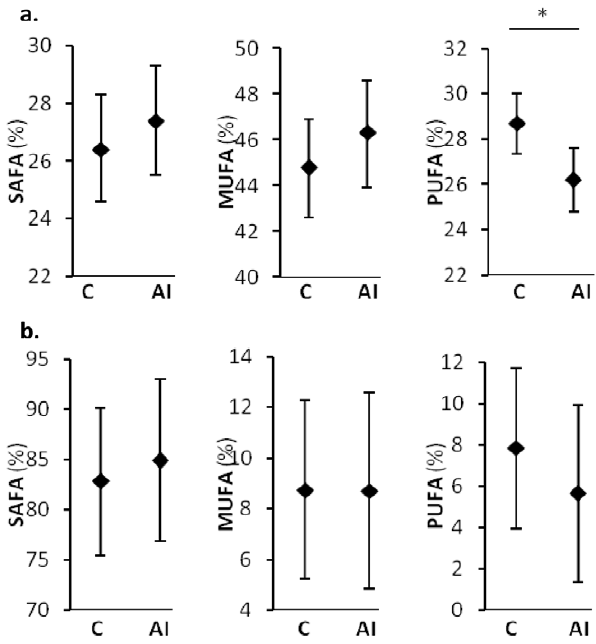
Figure 1. Plasma and CSF fatty acid fractions by race. Percentual abundance of saturated (SAFA), monounsaturated (MUFA) and poly- unsaturated (PUFA) fatty acids in plasma ( a. ) and CSF ( b. ) are shown for Caucasian (C) and American Indian (AI) individuals in plasma and CSF. Diamonds ( ¤ ) represent least squared means adjusted for age, sex, and body fat and error bars indicate 95% confidence interval. *P=0.01.